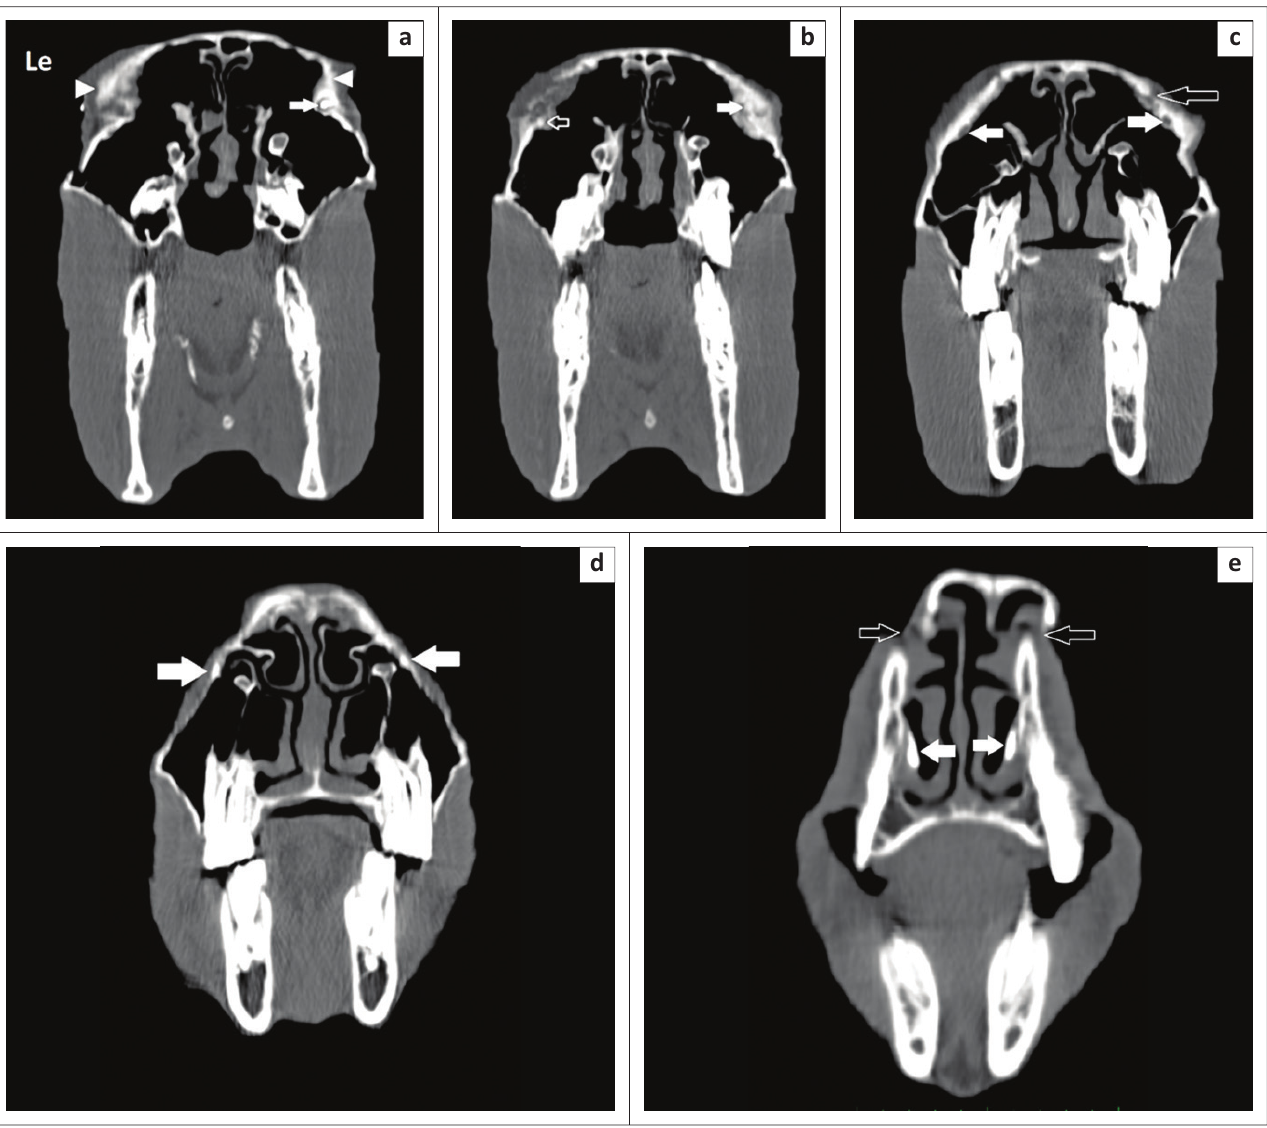
FIGURE 5: A sequence of slightly oblique transverse computed tomography images are presented from caudal (level of the medial canthus of the eyes) (a) to rostral (e). In (a), the contrast medium is present within the right ventral nasolacrimal puncta (white arrow) but is not visualised on the left. Note the marked bilateral lacrimal bone periosteal proliferation present (white arrowheads). In (b), the contrast material is not clearly visualised on the right (white arrow), in the region of the most severe bony proliferation, but is present on the left as a focal region of hyperattenuation (open arrow). In (c), at the level of the caudal maxillary molars, the contrast material is not visible in either nasolacrimal duct (white arrows), and a focal cortical defect in the lacrimal bone is visualised. In (d), a small amount of contrast attenuation can be visualised within both nasolacrimal ducts (white arrows) with the contrast present in the nasal passages (white arrows) in (e), immediately caudal to the nasal puncta. Note the discontinuity and displacement of the dorsal-most aspect of the nasal bones (open arrows), which is because of patient motion and thus is artefactual. The left (Le) of the patient is on the left of the image, and the dorsal is to the top. Images were obtained under standing sedation, in a bone window (WL: 450 HU and WL: 1500